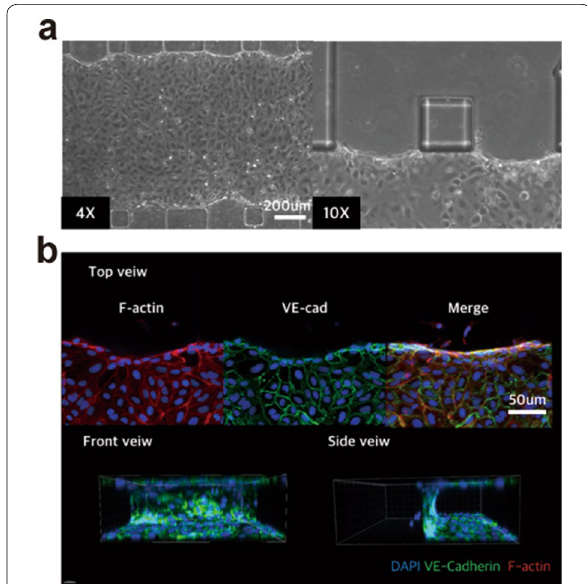
Fig. 2 The result images of microfluidic brain endothelial monolayer model at day 4. Phase images of brain endothelial cells in the microfluidic device at the bottom view ( a ) and the fluorescence images of them at the top, front and side view ( b ) were shown. The nucleus (blue), F‑actin (red) and VE‑cadherin (green) of brain endothelial cells in the microfluidic device was stained (scale bar 50μm) =